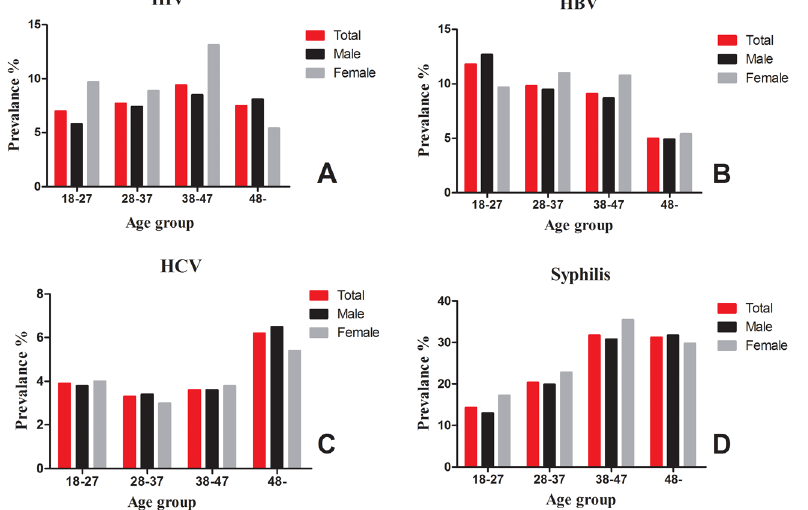
Fig 2. The distribution of the TTI seroprevalence rates among the blood